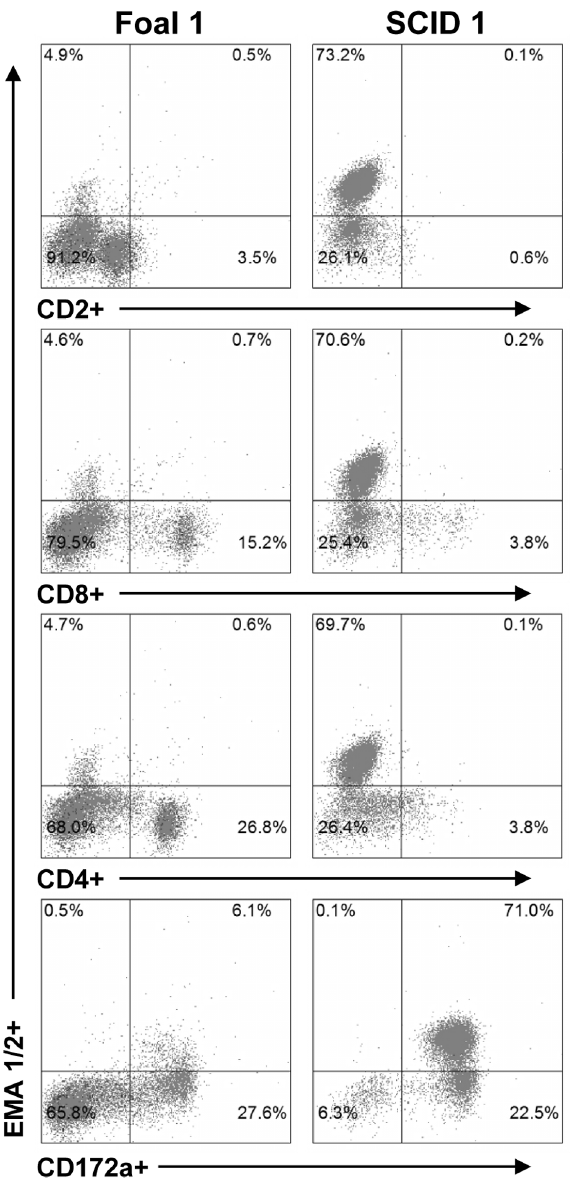
Figure 6. Immunophenotype of immunocompetent and SCID foal PBMC containing T.equi antigen exvivo . PBMC from Foal1 (48 DPI) and SCID1 (15 DPI) were analyzed post-infection by flow cytometry to determine the percentage of CD2 + , CD8 + , CD4 + , and CD172a + cells that contained T. equi antigen (EMA 1/2).